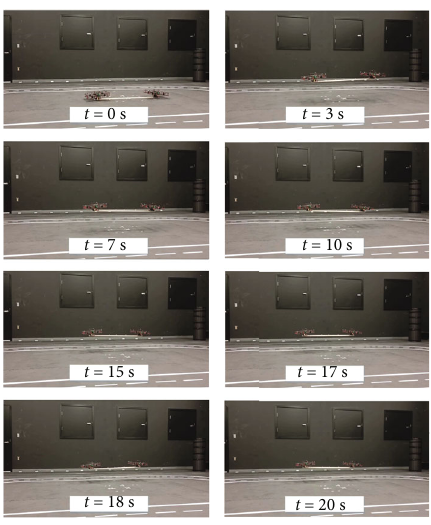
Figure 6: The snapshots of the test in X direction.